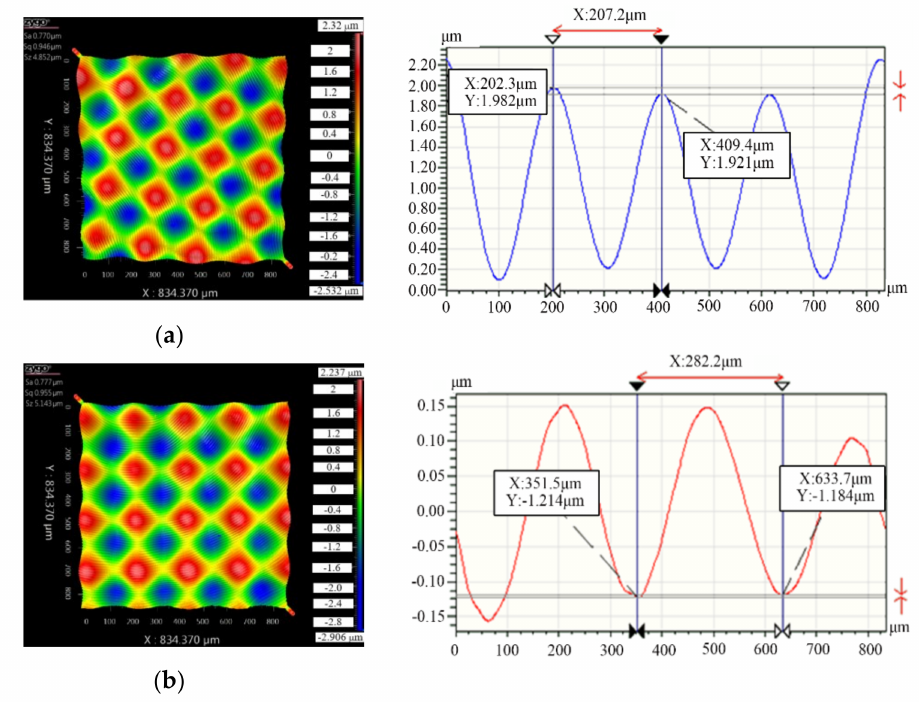
Figure 7. Effect of the number of sampling points on the profile of sinusoidal microstructures. Number of sampling points: ( a ) 7200 d/r; ( b ) 5700